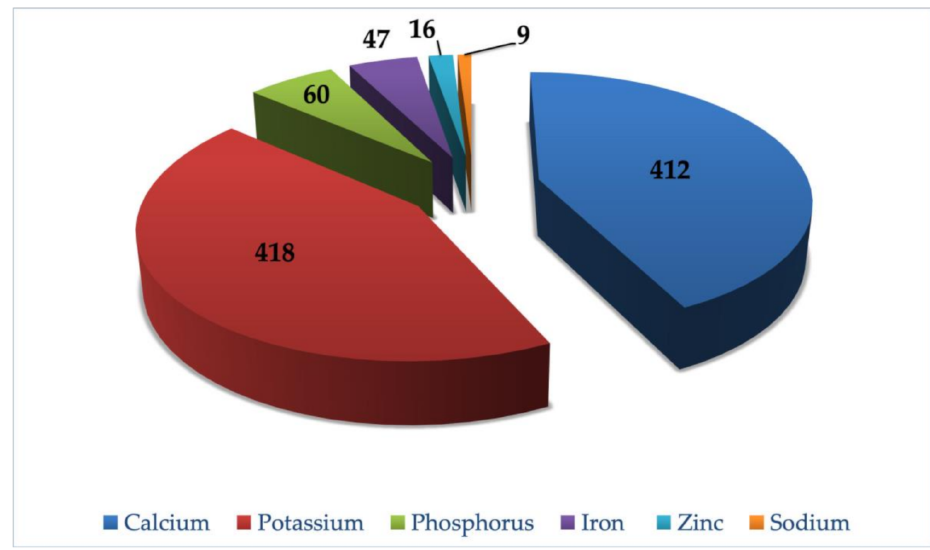
Figure 3. Mineral contents (mg/100 g) of okra mucilage